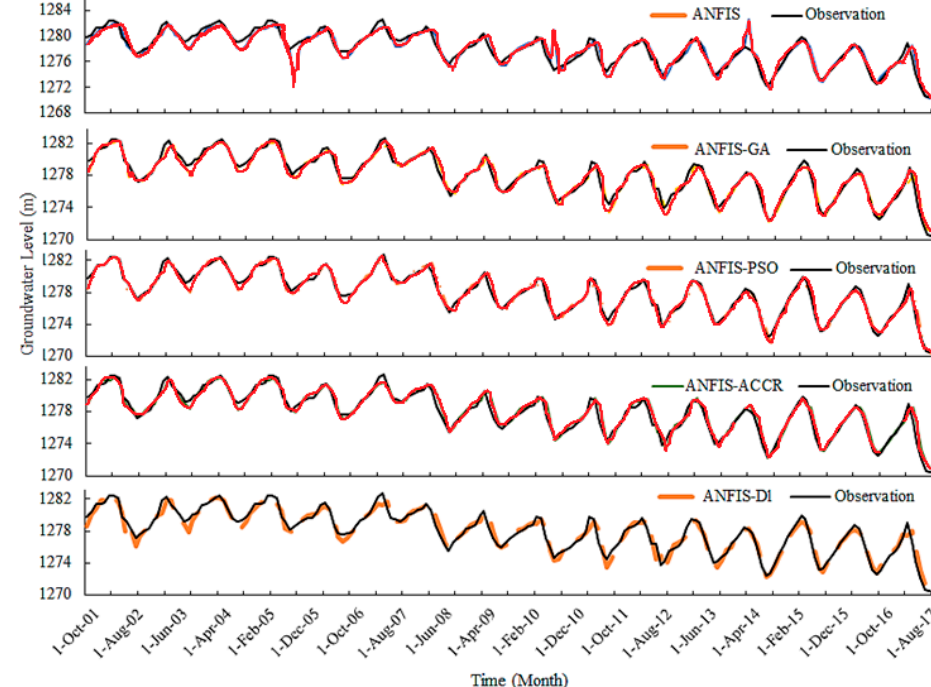
Figure 11. Observation and prediction data of the studied period for the well P2.